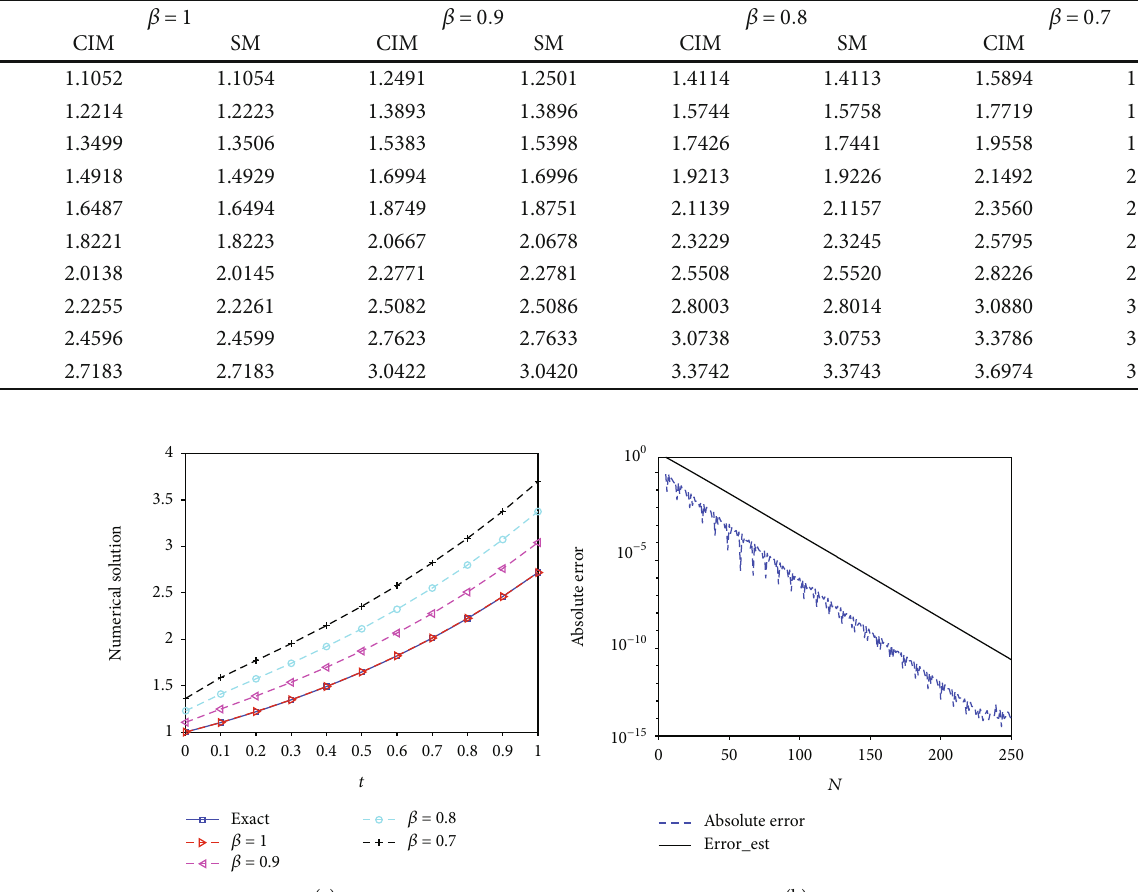
Figure 5: In (a), the numerical solutions for various values of β corresponding to Problem 3 are shown. In (b), absolute error vs. error estimates for β = 1 are